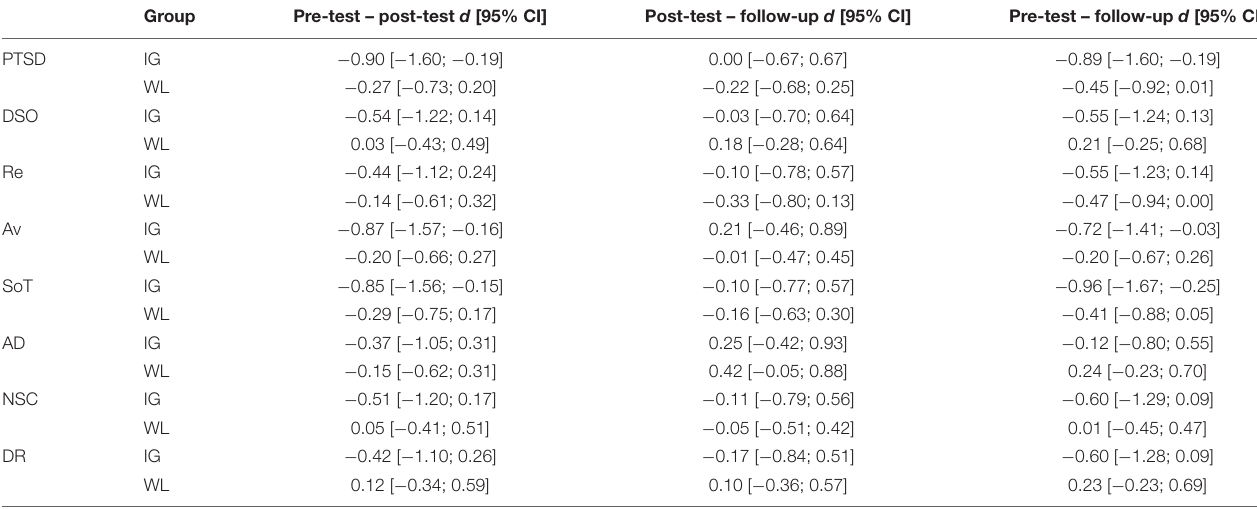
TABLE 2 | Within-group effect sizes.